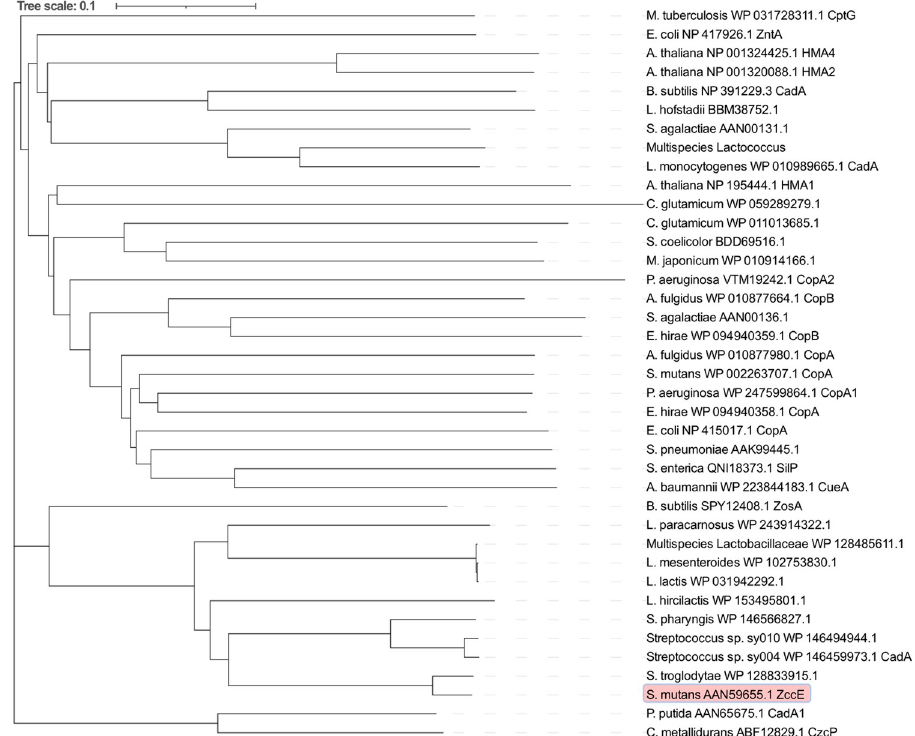
Fig 3. Phylogenetic tree of P-type ATPases including ZccE and 38 other P-type ATPases identified from the literature and from BLASTP searches for comparison. The tree distance is the calculated distance from the multiple sequence alignment in Clustal Omega. ZccE is highlighted in